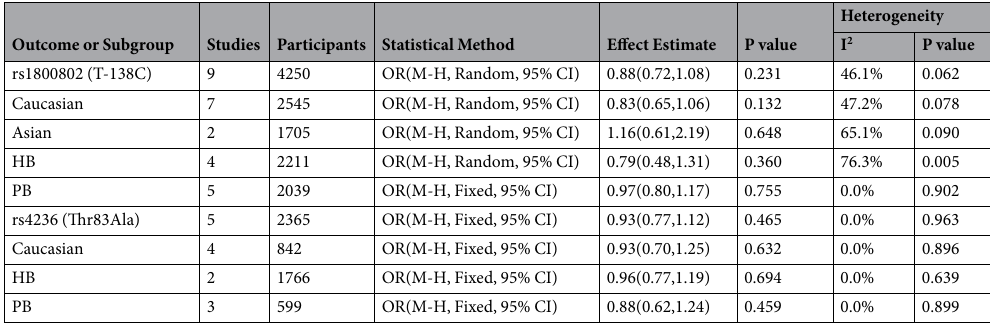
Table 2. Genotype distribution and allele frequency of the three MGP gene (rs1800801, rs1800802, rs4236) polymorphisms in cases and controls. OR, odds ratio; CI, confidence intervals; I 2 = I-square; PB, population based; HB — hospital